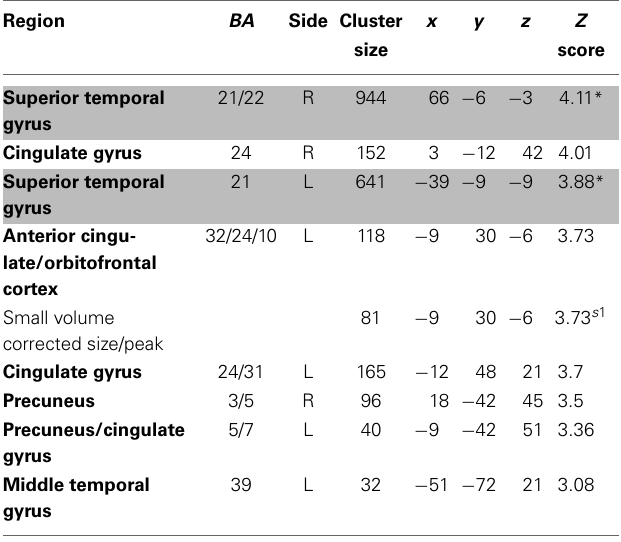
Table 4 | Regions positively correlated with relative discounted stimulus value at the time of choice in